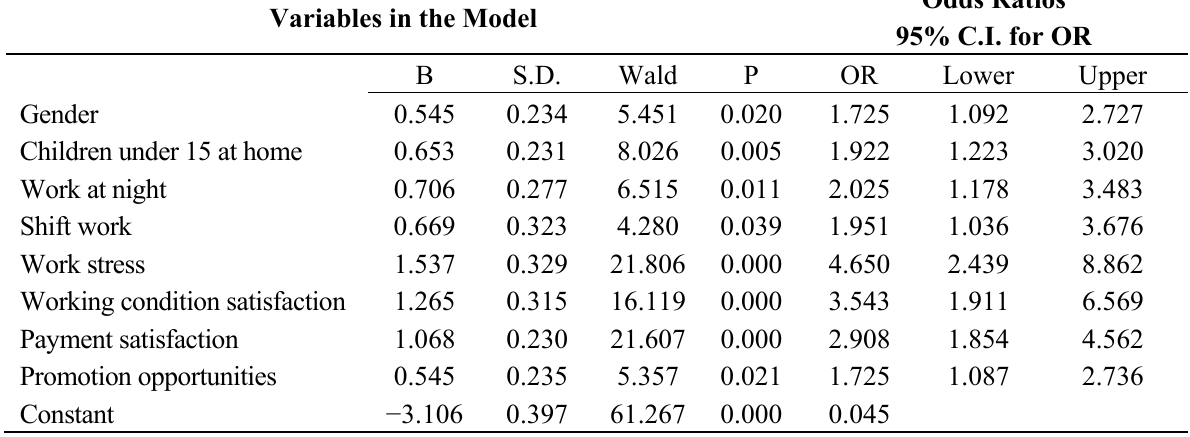
Table 5. Logistic regression: factors that determine workplace bullying (Confidence intervals for the odds ratio of Model